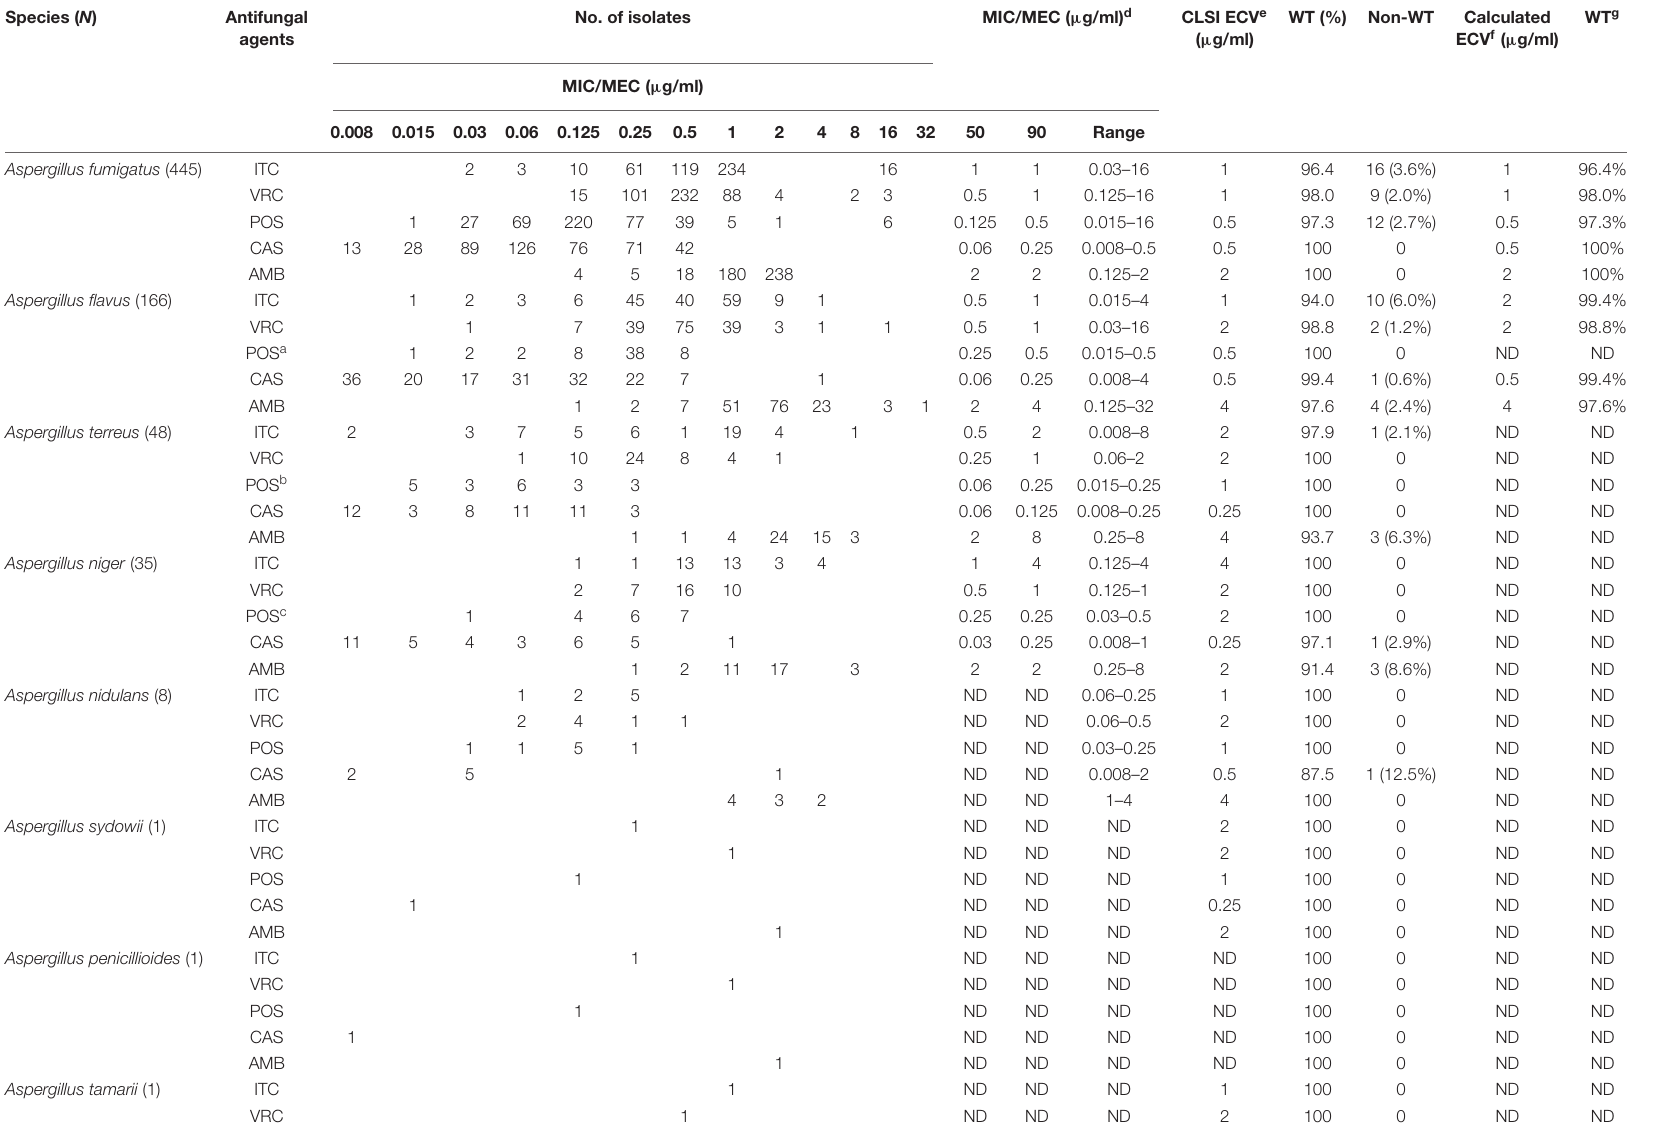
TABLE 2 | In vitro susceptibilities of the 706 Aspergillus spp. isolates against five antifungal agents and proposed ECVs for Aspergillus fumigatus and Aspergillus flavus obtained using CLSI M38-A3 broth microdilution